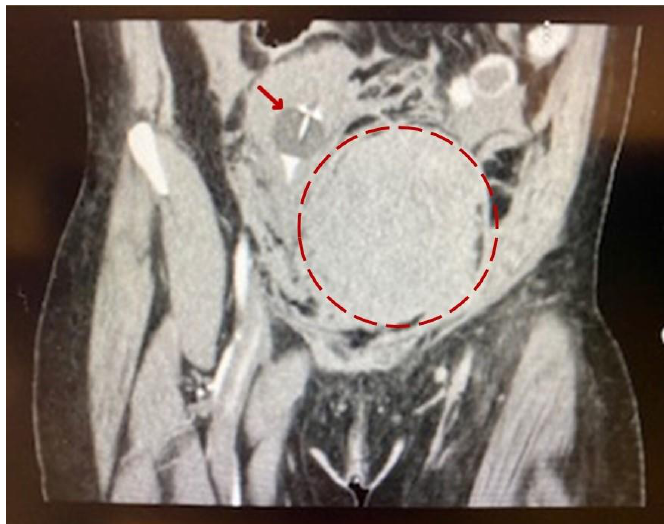
Image 2. Repeat computed tomography of the abdomen and pelvis three hours later, with significantly expanded hematoma. Foley in compressed urinary bladder and bladder displaced. Red arrow : Foley in compressed urinary bladder and bladder displaced. Dashed circle : expanded pelvic